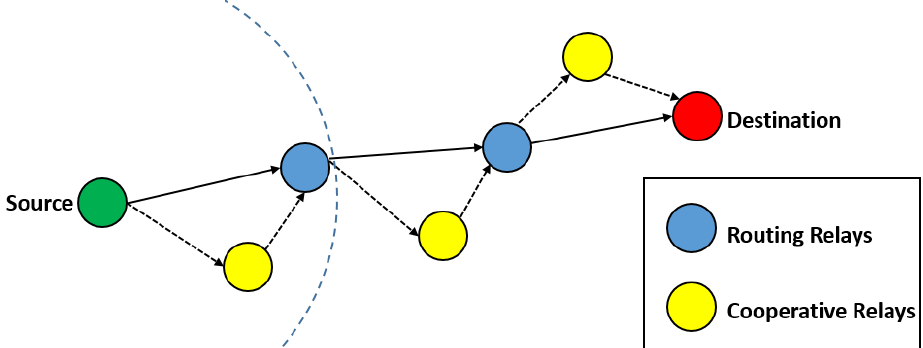
Figure 21. Cooperative routing.